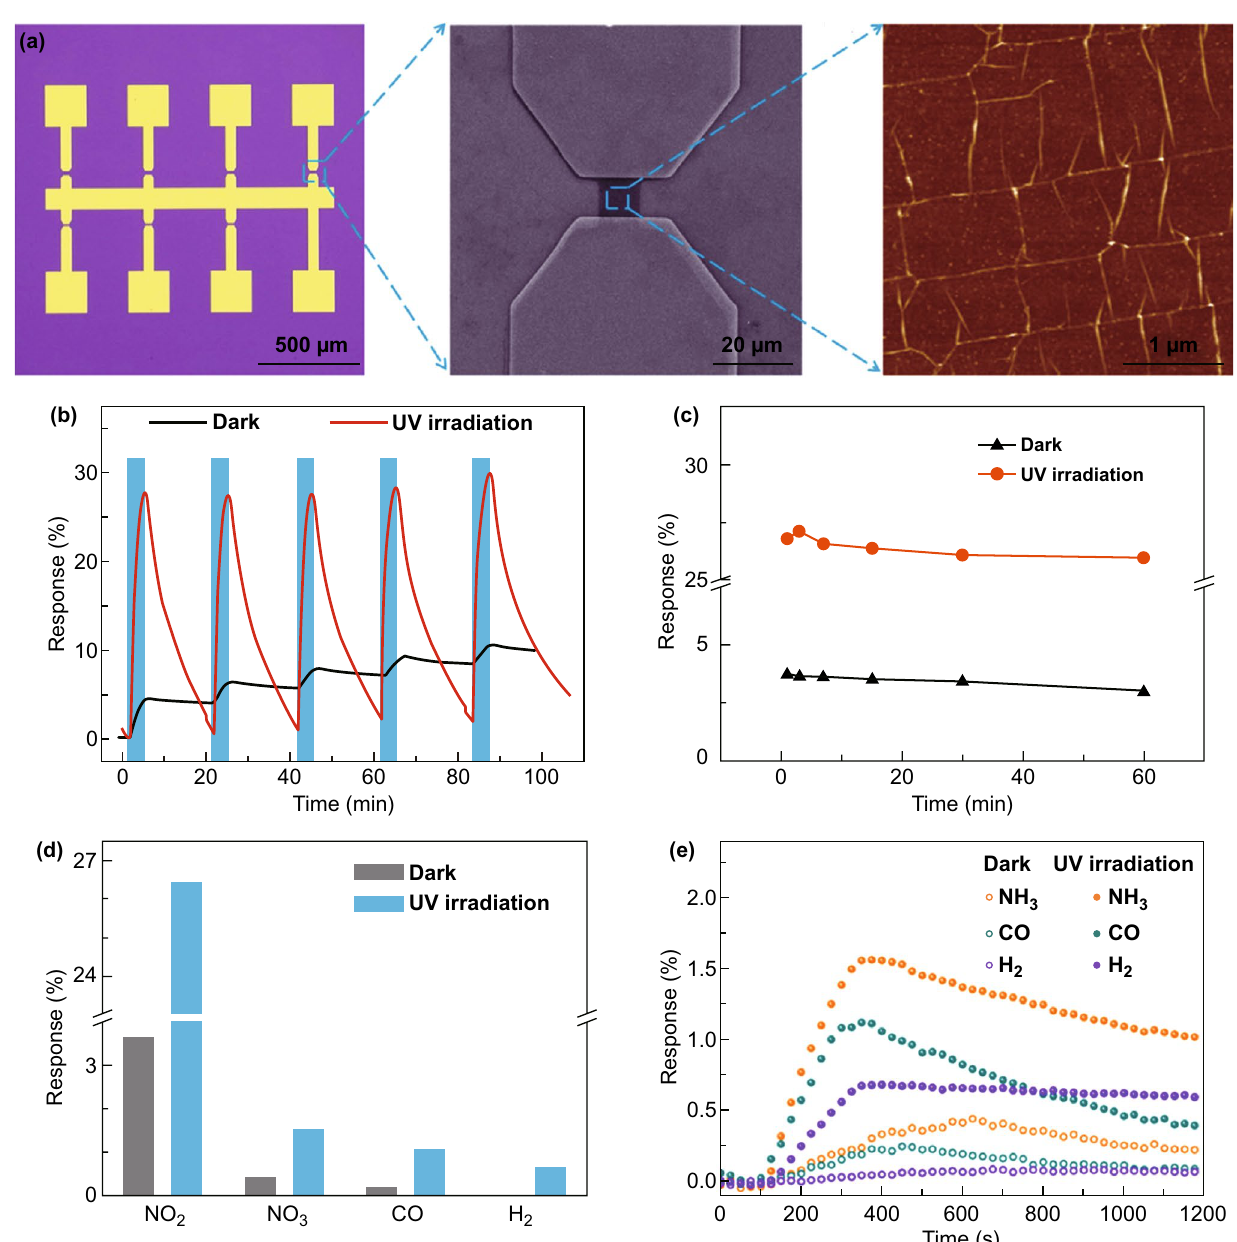
Fig. 9 a Optical image of graphene sensors array, SEM image of graphene device, and AFM image of graphene. b Response and c stability test of graphene sensor to 100 ppm NO 2 in dark and UV illumination. d Selectivity bar diagram, and e transient response of graphene sensor to NH 3 , CO and H 2 at room temperature in dark and UV illumination. Reproduced with permission [87]. Copyright 2019, American Chemical